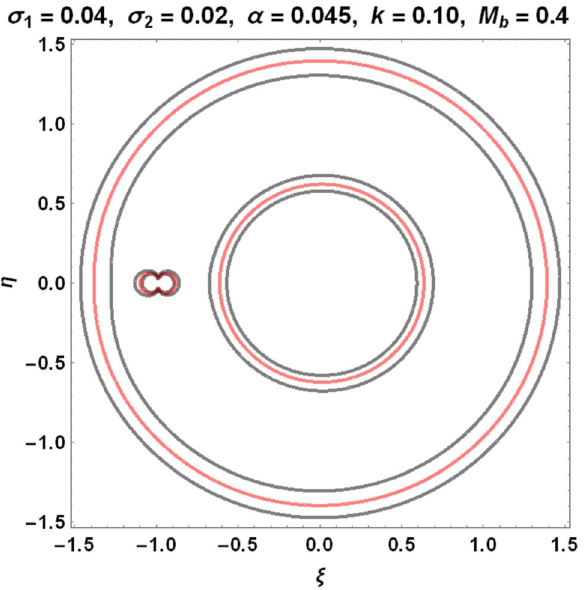
= 0.01215, e = 0.0549, a = 1.000453, A = 0.0000003686, T = 0.01, Figure 4. Zero velocity curves for µ